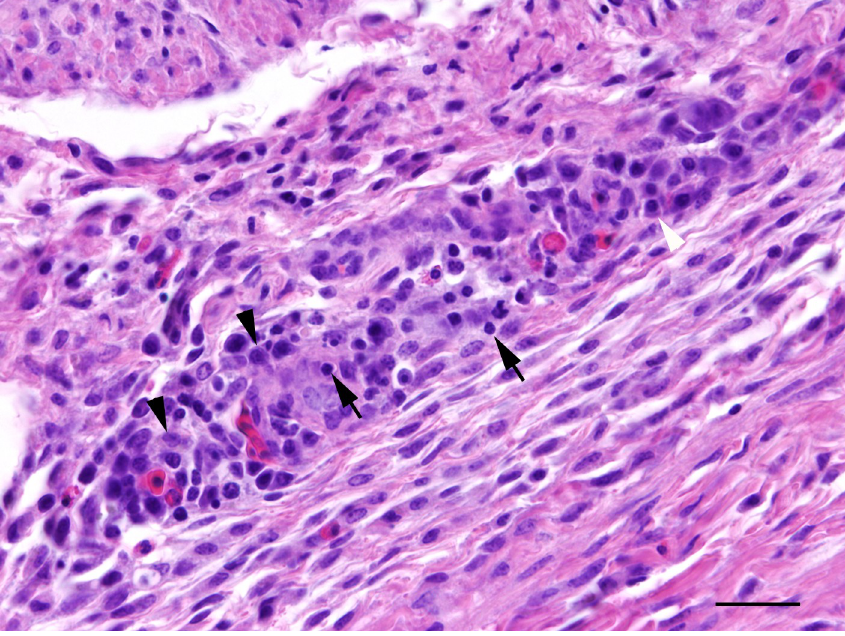
Fig 2. Pheasant chick with moderate perivascular dermatitis of the skin of the scalp with infiltration of lymphocytes (arrows), macrophages (black arrowheads) and few plasmacells (white arrowhead); HE, bar = 60 μ m.